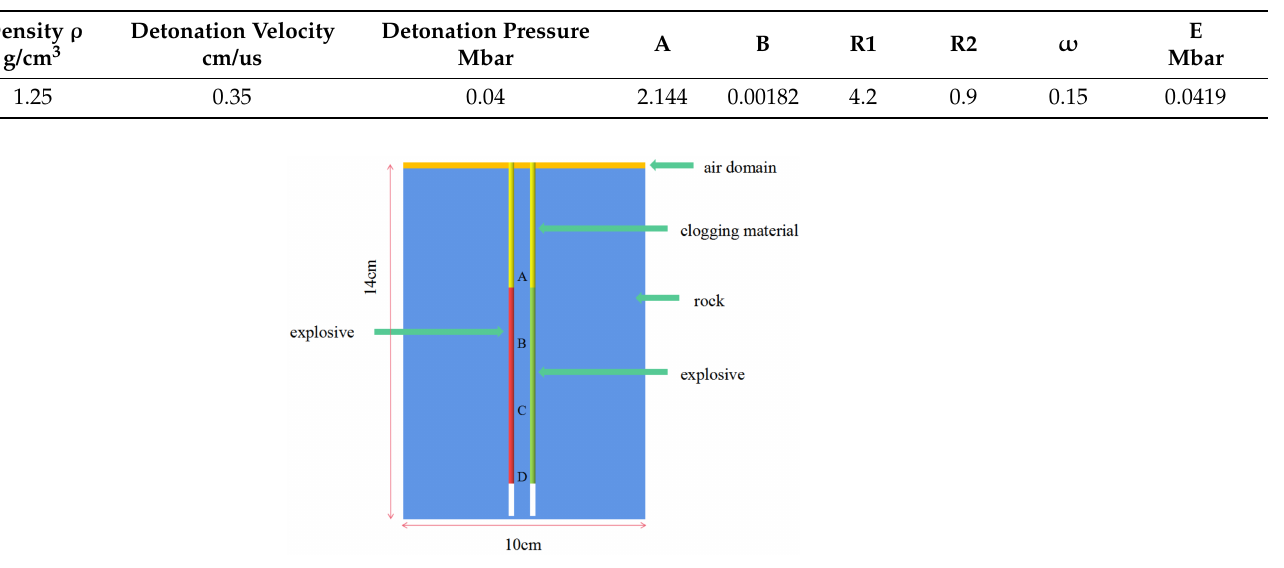
Figure 11. Blocking setting schematic